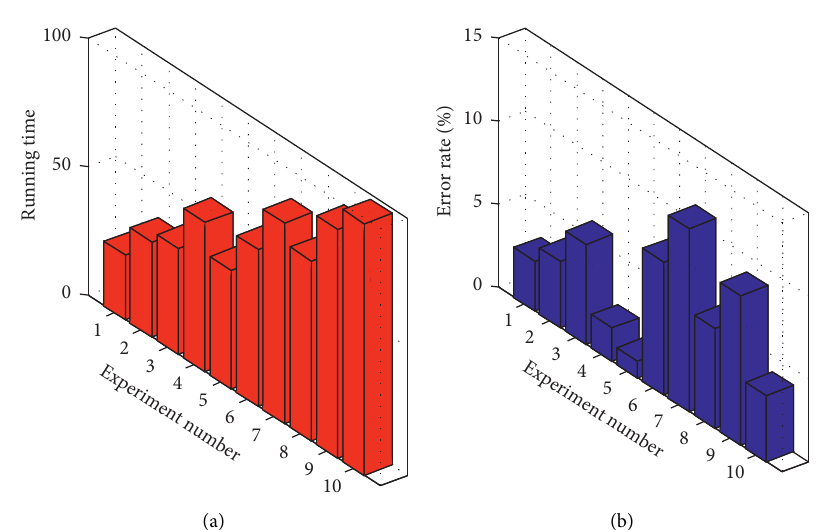
Figure 10: Test results of the deep neural network on the data set. (a) Running time. (b) Error